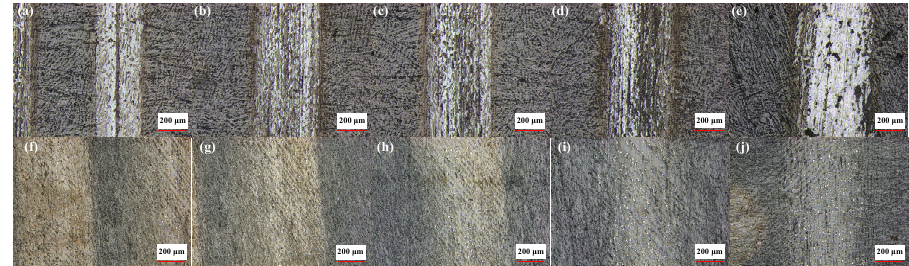
Figure 12. Wear scar morphology of 25 wt. % initial solid phase content composites with a rotational speed of 200 r/min under dry friction conditions: ( a ) load:1 N; ( b ) Load: 2 N; ( c ) Load: 3 N; ( d ) Load: 4 N; and ( e ) load: 5 N. Wear scar morphology of 25 wt.% initial solid phase content composites with a rotational speed of 200 r/min under water-based drilling fluid conditions: ( f ) Load: 1 N; ( g ) Load: 2 N; ( h ) Load: 3 N; ( i ) Load: 4 N; and ( j ) load: 5 N.